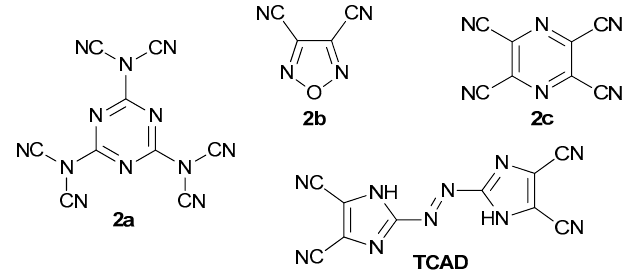
Figure 2. Structures of known energetic polynitriles.